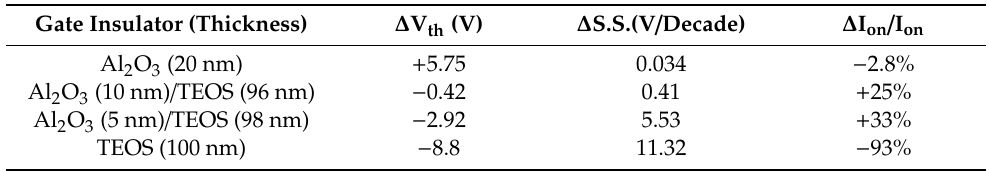
Figure 3. Representative transfer characteristics of a-IGZO TFTs with ( a ) Al 2 O 3 (20 nm), ( b ) Al 2 O 3 (10 nm) / TEOS oxide (96 nm), ( c ) Al 2 O 3 (5 nm) / TEOS oxide (98 nm), and ( d ) TEOS oxide (100 nm) gate dielectrics, respectively, as a function of stress time under a positive bias stress (PBS) (V GS = + 20 V). Table 2. Variations of extracted electrical parameters of a-IGZO TFTs with four kinds of gate dielectrics after PBS stress for 6400 s (V GS = + 20